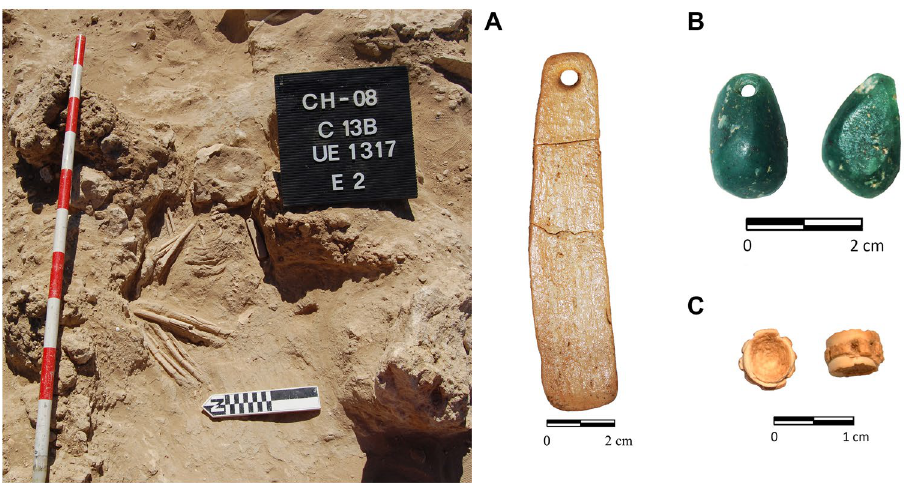
Figure 9. Infant burial E2T13B and grave goods, consisting of a bone pendant with a bevelled edge ( A ), a green mica pendant ( B ), and a possible pendant carved on a elasmobranch vertebra ( C